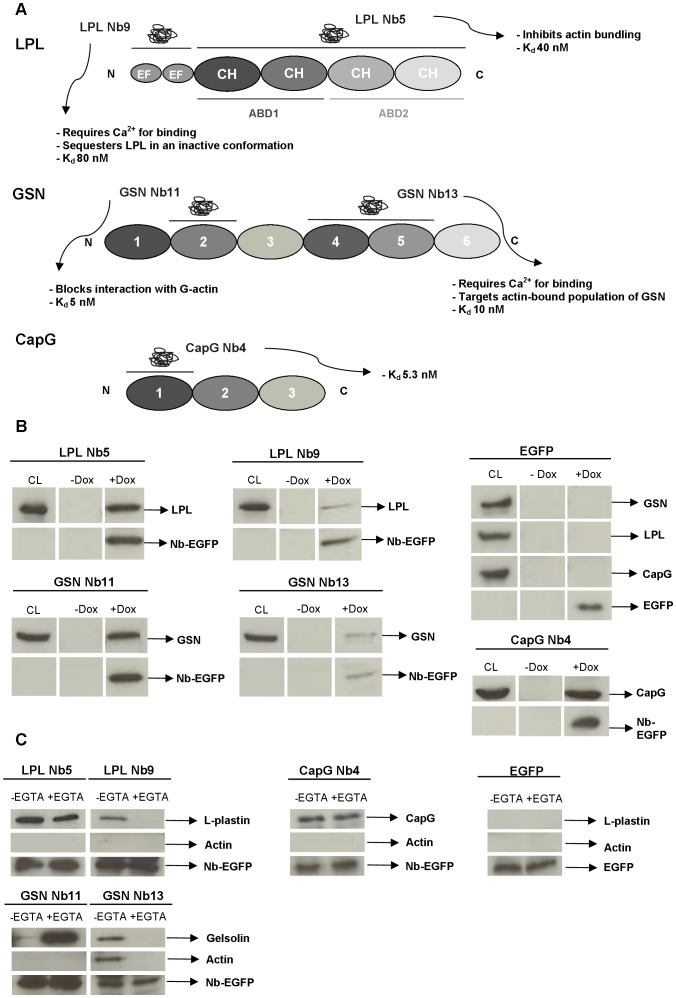
Nbs targeting distinct structural domains of L-plastin, gelsolin and CapG, interact specifically with their target.(A) LPL consists of two N-terminally located EF-hands (EF) and two C-terminally located ABDs. Both ABDs are divided into two calponin homology (CH) domains. LPL Nb9 recognizes the EF-hands, whereas LPL Nb5 binds the two ABDs combined. Gelsolin consists of six homologous domains, whereas CapG consists of 3 domains. GSN Nb11 recognizes the N-terminal part (domain 2) and GSN Nb13 binds to domains 4 and 5 combined (C-terminal part). CapG Nb4 binds to the first domain of its target. (B) THP-1 cells expressing EGFP-tagged LPL/GSN/CapG Nbs or EGFP were generated by stable transduction; expression of these constructs is induced by doxycycline. Cell lysates were incubated with a polyclonal EGFP antibody, followed by binding on protein G sepharose to immunoprecipitate the EGFP-tagged Nbs or EGFP. The blots were stained for L-plastin, gelsolin or CapG and EGFP to demonstrate the interaction between the expressed Nb and its target in the presence of doxycycline. (C) Co-immunoprecipitations experiments as described in (B) were conducted in the absence or presence of EGTA. The blots were stained for L-plastin, gelsolin or CapG, EGFP and actin. Blots are representative for four independent experiments. CL: crude lysate, DOX: doxycycline.